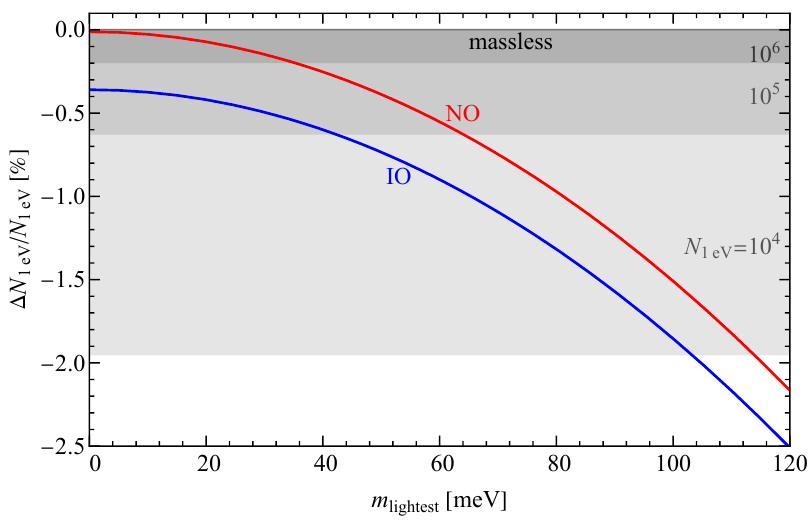
Figure 7 . Percentage variation in the number of events in the final 1 eV of the tritium energy distribution as a function of the lightest active neutrino mass. The red line denotes the normal ordering case and the blue line the inverted ordering. The gray bands denote the 95 % CL for a detectable change in the rate as a function of the total number of events in the final